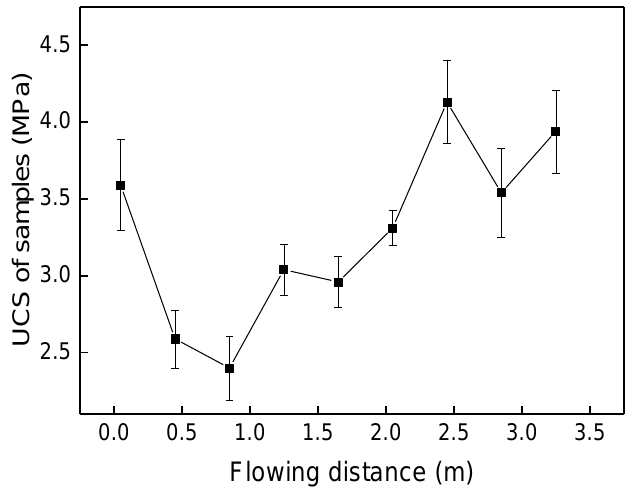
Figure 6. The strength distribution of backfill samples along the flowing direction.